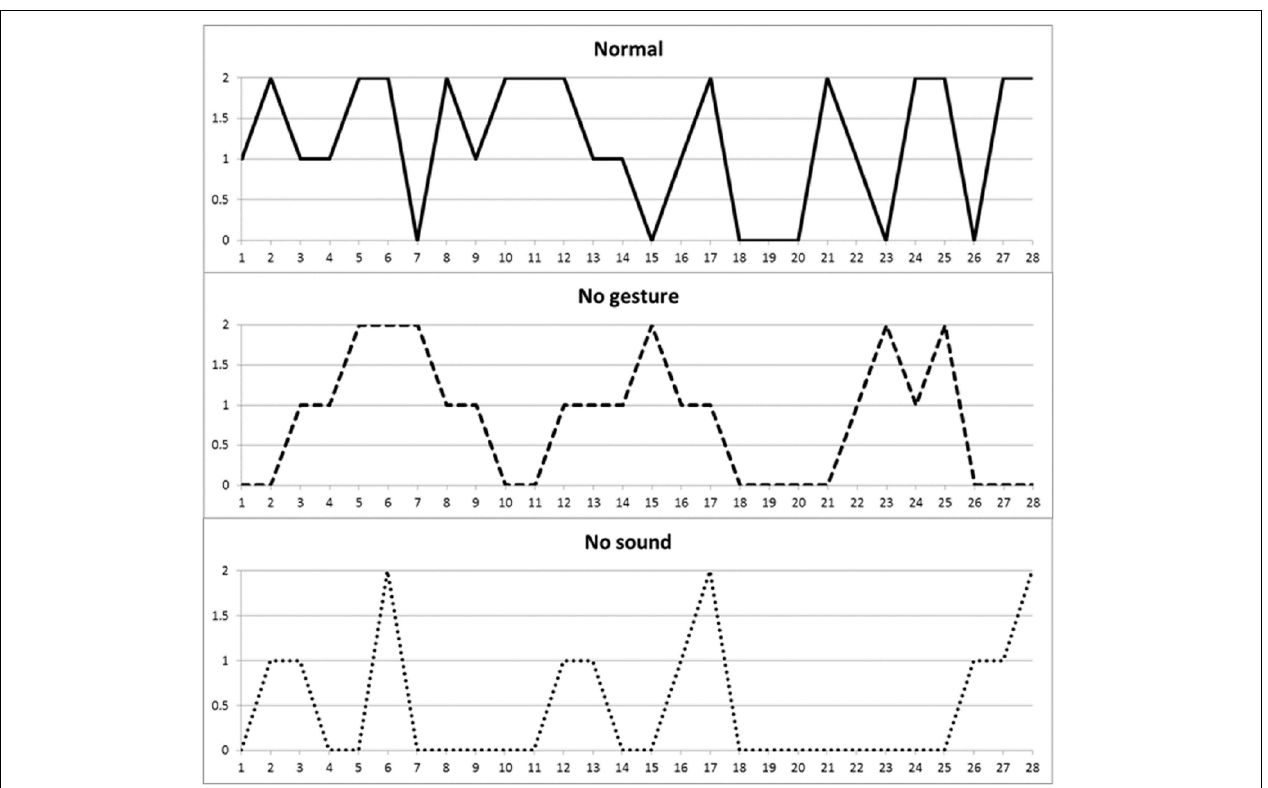
FIGURE 2 | Individual Limbs Movements of K. playing Head, Shoulder, Knees, and Toes in the three conditions. The order of condition presented was normal, no-sound and no-gesture. A score of 2 indicates that